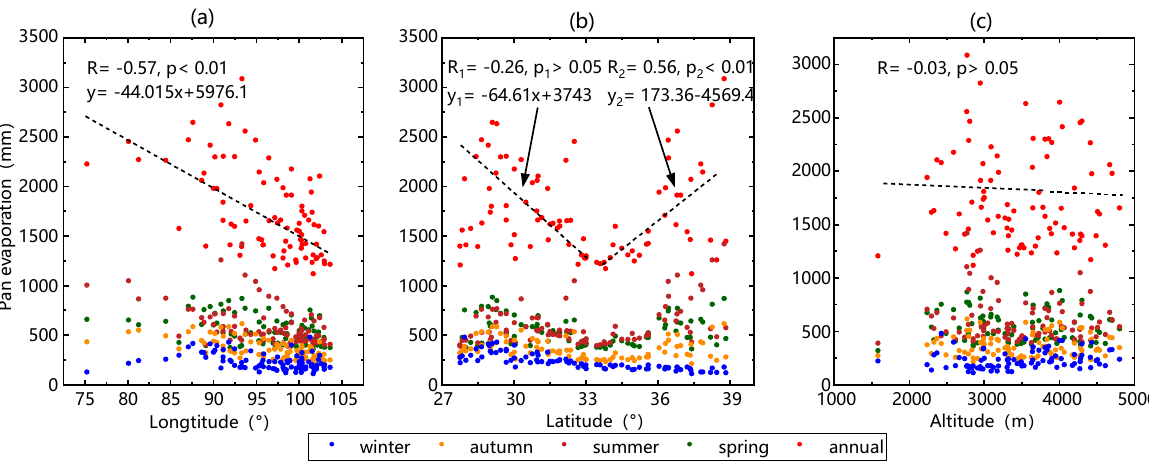
Figure 9. Correlation of the annual and seasonal mean Epan with longitude ( a ), latitude ( b ), and altitude ( c ) at each site on the TP.